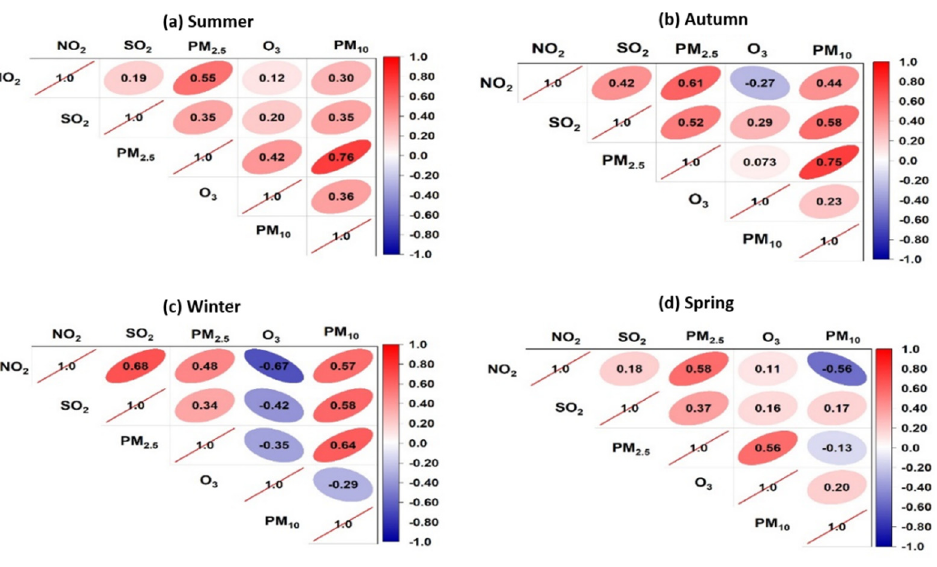
Figure 9. Pearson’s correlation coefficients among different pollutants for ( a ) summer, ( b ) autumn, ( c ) winter, and ( d ) spring over